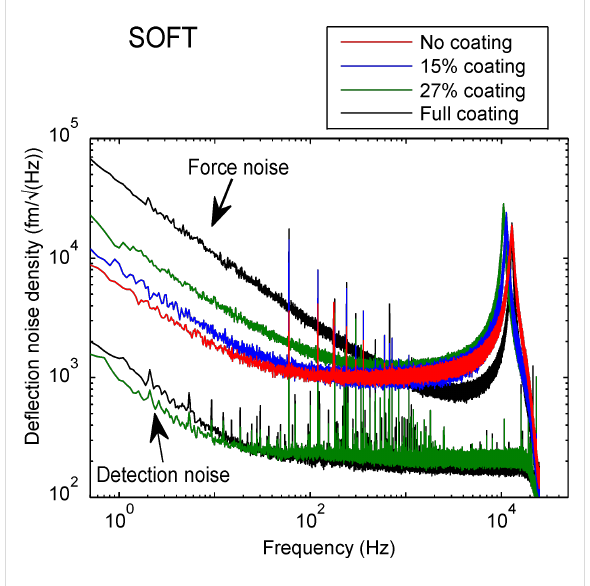
Figure 2: Noise spectra for soft cantilever with different coating coverage acquired in air. Fully coated cantilever shows the highest 1/ f noise. The 1/ f noise reduces with reduced coating coverage. The uncoated cantilever shows the lowest 1/ f noise level.